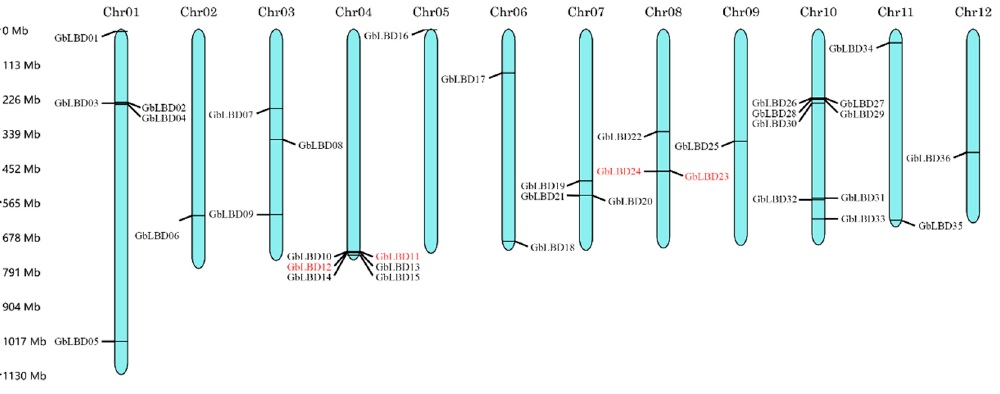
Figure 3. Chromosomal localization of 36 GbLBD , chromosome number at the top of each chromo- some. Four genes in red font indicate the two gene clusters formed. The scale was in MegaBase (Mb).